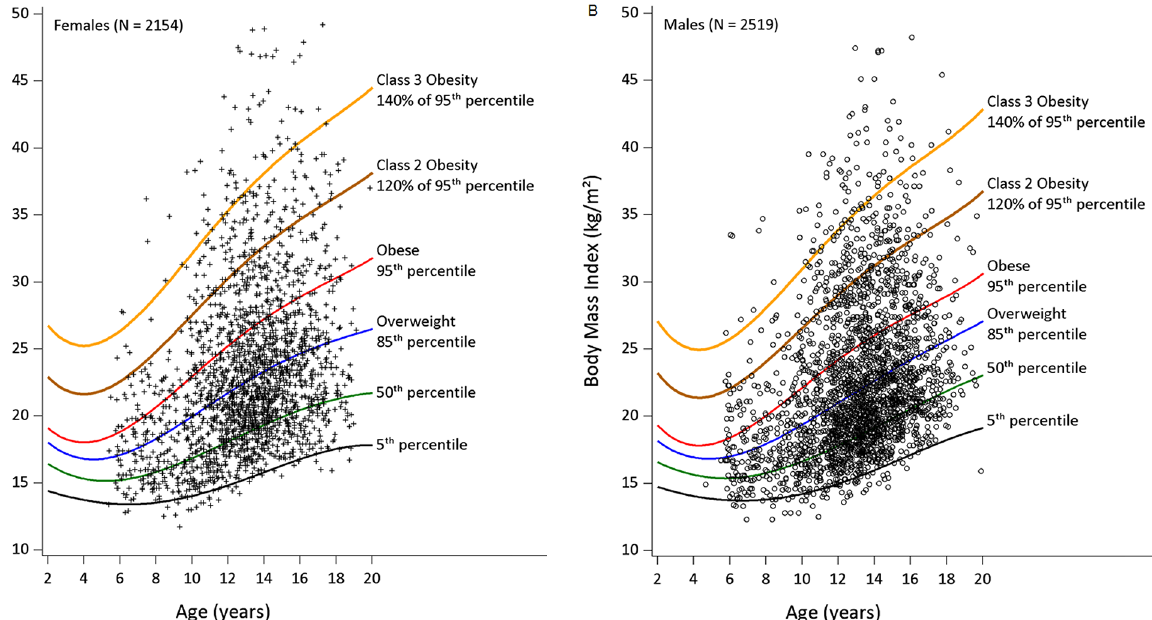
Fig 1. Body Mass Index and BMI-for-age Percentiles of Urban Female and Male Students. Body mass index (BMI) for female students (A) and male students (B) depicted on BMI-for-age percentile growth charts [14]. Each symbol represents one student ’ s BMI (N = 4673). Severe obesity was defined as class 2 obesity ( (cid:1) 120% of the 95 th percentile of BMI-for-age) or class 3 obesity ( (cid:1) 140% of the 95 th percentile) [2].